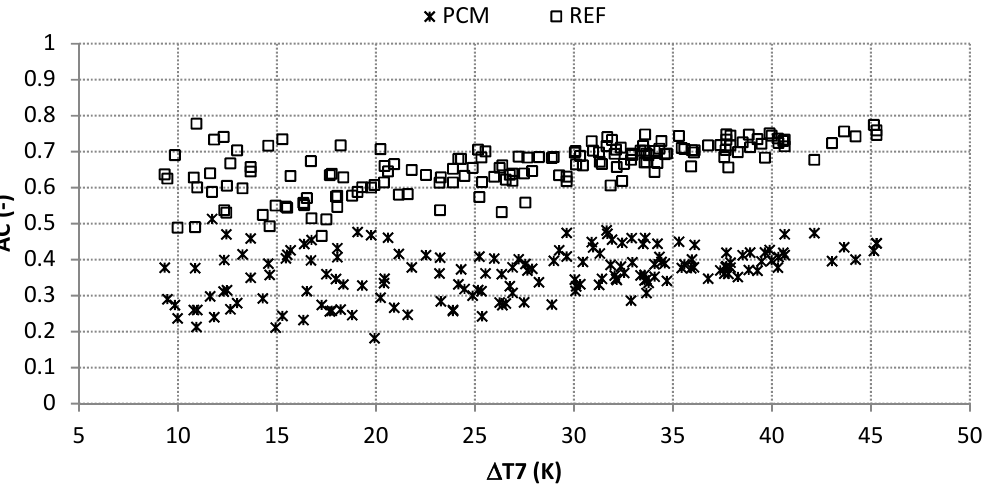
Figure 10. Dependence of AC on daily external temperature fluctuations.